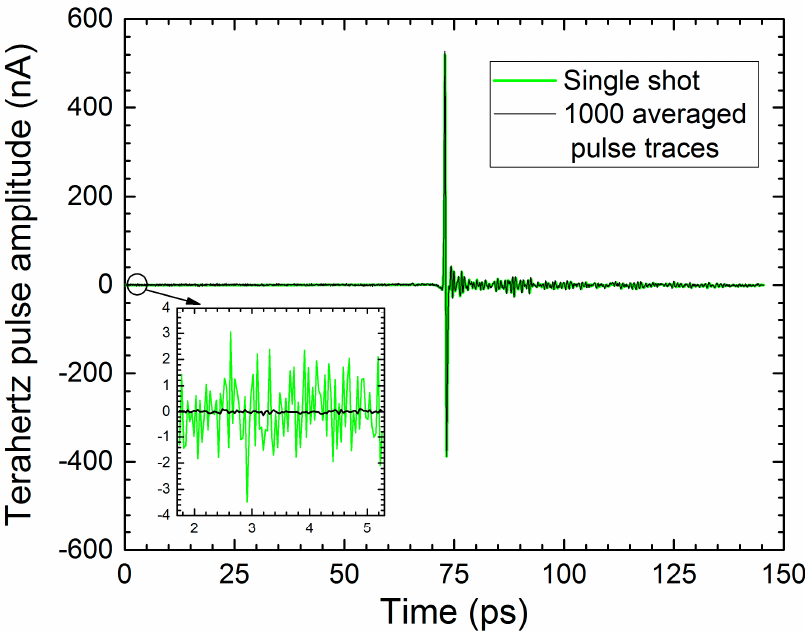
Figure 2. Single-shot terahertz pulse trace (green) taken at a measurement speed of 1600 traces per second, and average of 1000 consecutive pulse traces (black). The inset shows a magnified cutout of the pre-pulse noise floor.